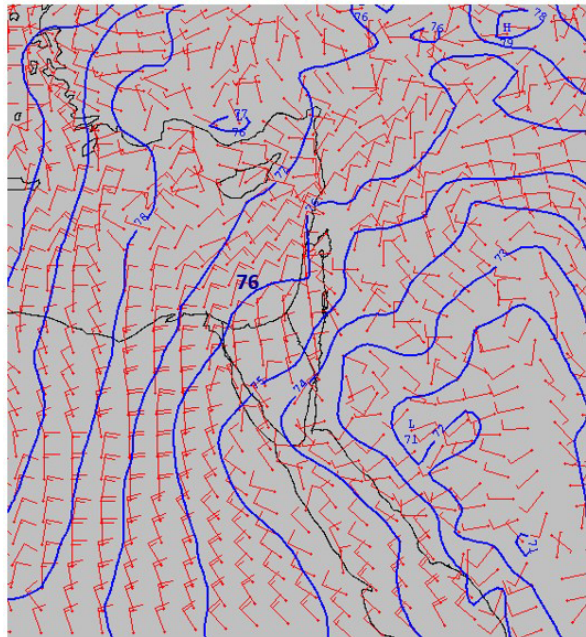
Figure 2. The 925mb map from 7 September 2015 at 12:00UTC of 76dm geopotential height over Israel (blue lines indicate the 1dm interval) and wind (red arrows; each line indicates 10KT). Source: IMS from the British Met Office (UKMO)